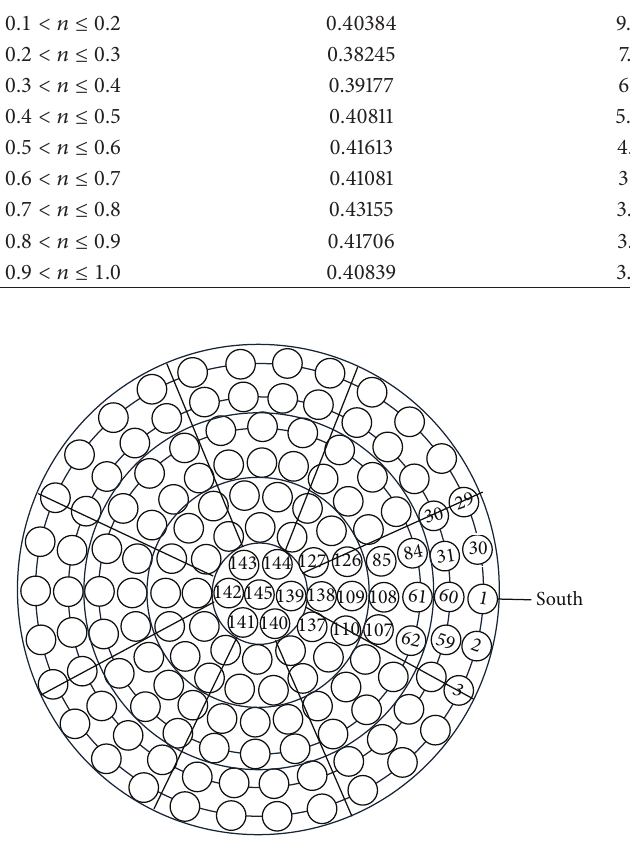
Figure 11: The position of the sky zones used for the model validation.